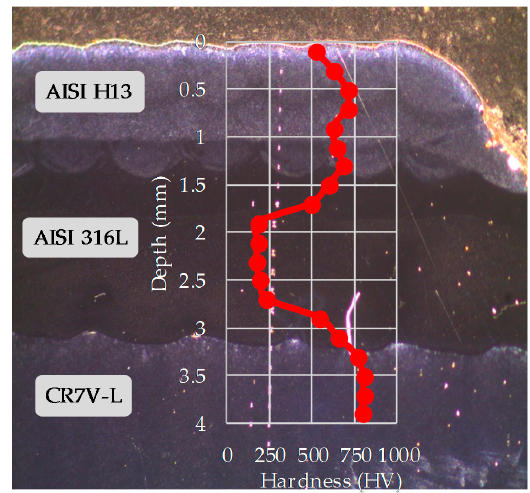
Figure 12. Vickers hardness values of the deposited materials and substrate.